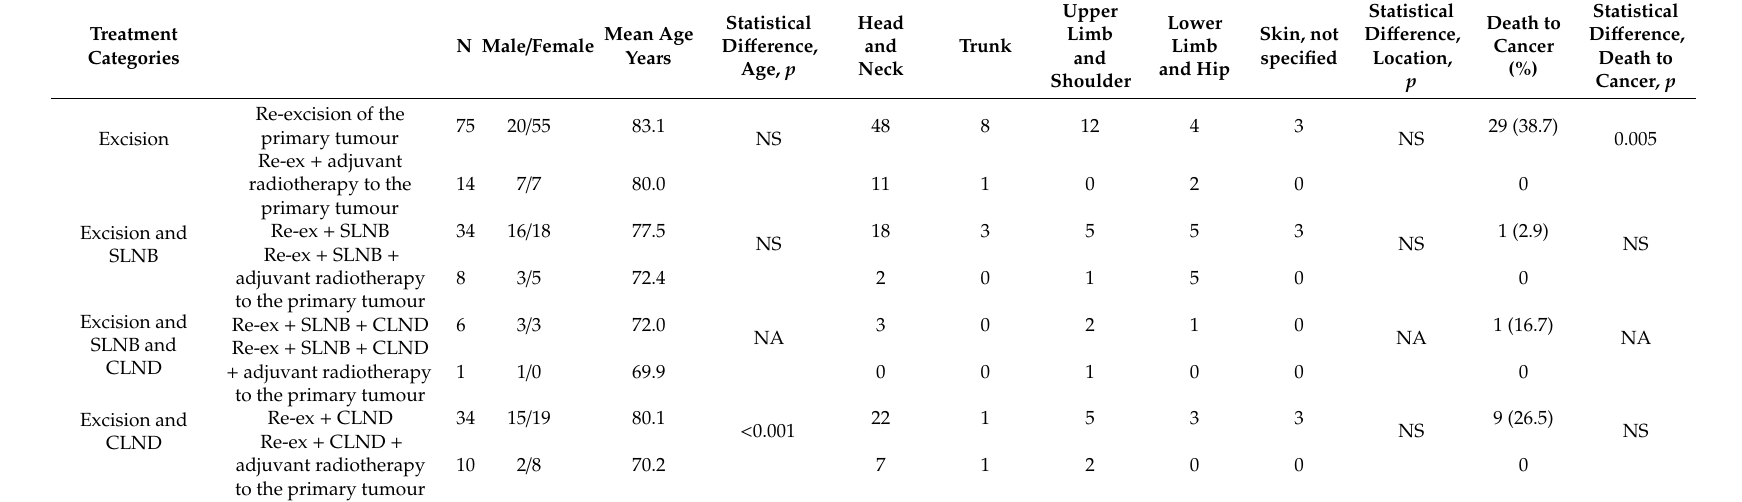
Table 4. Comparison of the e ff ect of adjuvant radiation therapy to the primary tumour after excision in patients diagnosed in the year 2005 onwards. Treatment